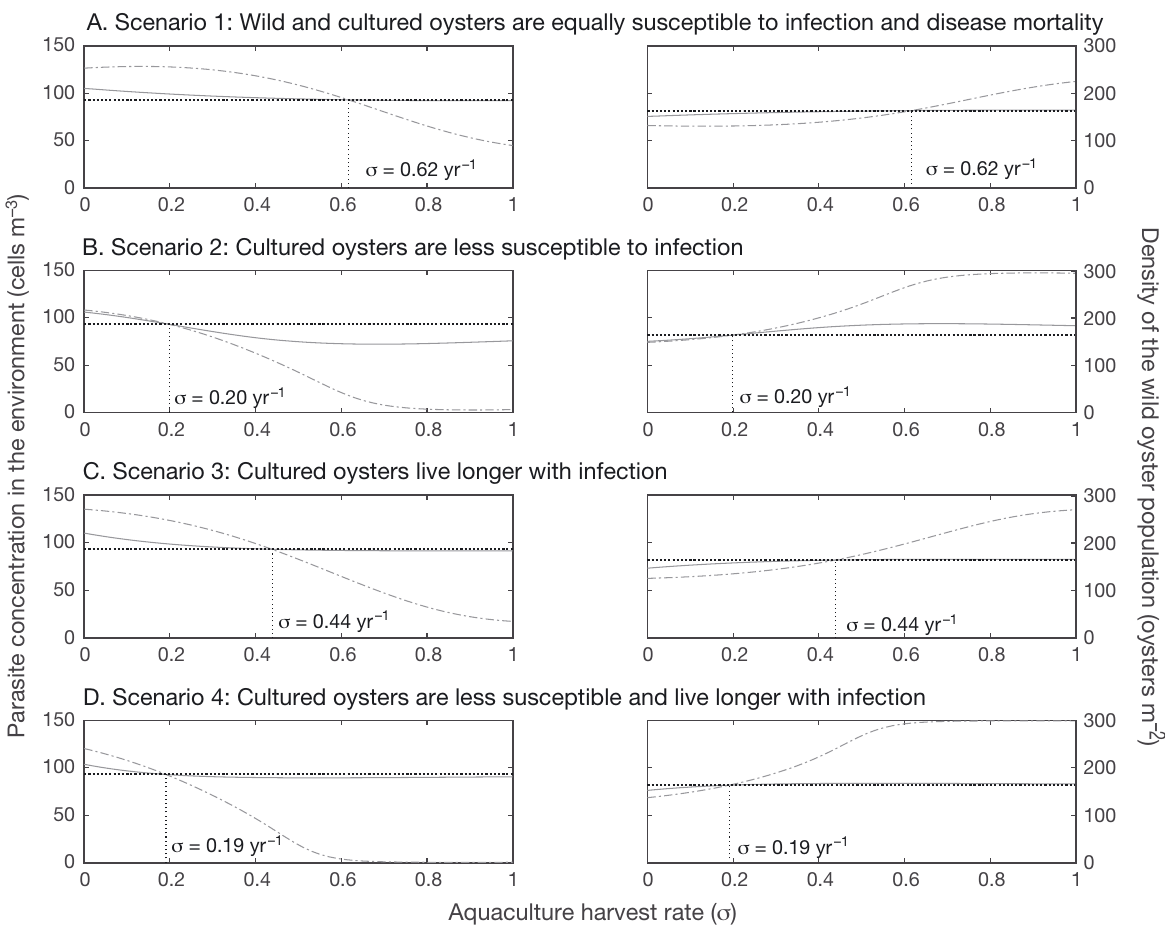
Fig. 3. Equilibrium concentration of Perkinsus marinus in the environment (left column) and the density of wild oyster popula- tions (oysters m −2 ) as a function of the aquaculture harvest rate ( σ ). Solid lines: aquaculture planting rate ( π ) of 10 oysters m −2 yr −1 ; dashed lines: planting rate of 1000 oysters m −2 yr −1 ; horizontal dotted lines: the equilibrium concentration of P. marinus in the environment and density of the wild oyster population in the absence of aquaculture; vertical dotted lines: the threshold values of the aquaculture harvest rate that lead to a decrease in parasite concentrations in the environment and an increase in the density of the wild oyster population. For the simulated Scenarios 1 to 4, increasing the aquaculture harvest rate increased the density of the wild oyster